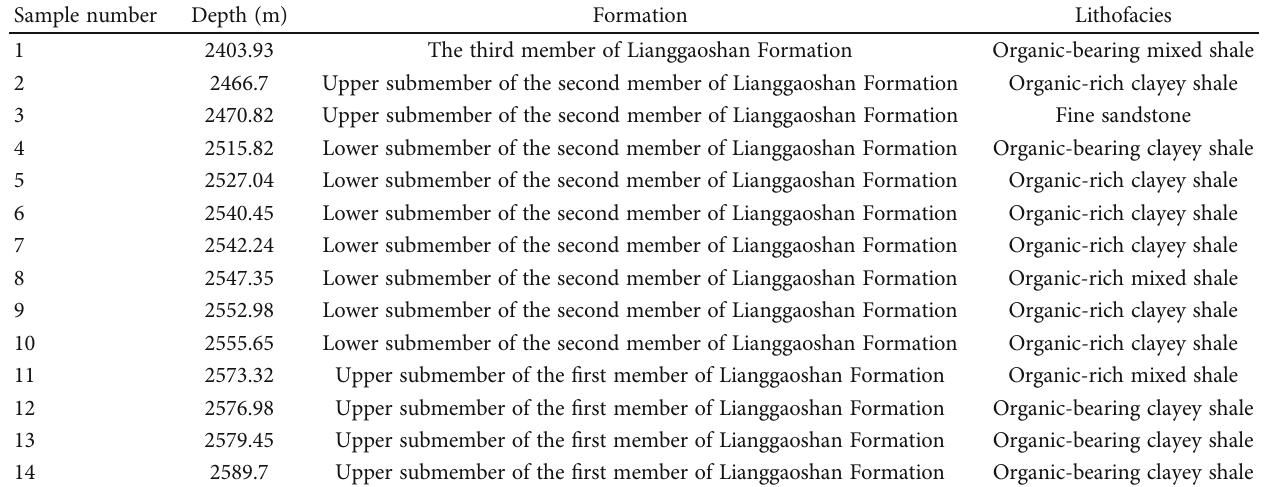
Table 1: Experimental sample depth, layer section, and petrographic classi fi